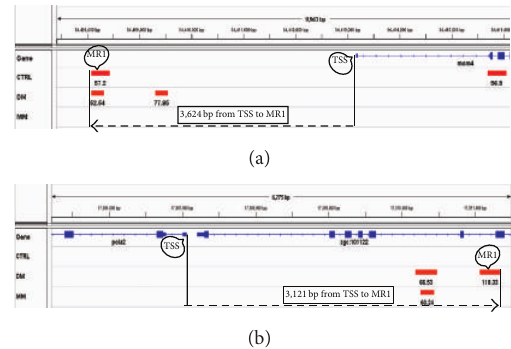
Figure 6: Methylated DNA regions (MRs) of zebrafish gene loci for mcm4 (a) and pola2 (b). Panels (a) and (b) were prepared with IGV genome viewer. The scale on the top shows chromosomal coordinates. This program schematically represents the structure of thegeneusingconventionalelements:(1)bluelinerepresentsintrons and (2) blue blocks on the line represent exons. Circles with the “TSS” point to the transcription start site and the dashed arrow points in the direction of 5 󸀠 to 3 󸀠 of the DNA strand with the arrow pointing to the MR farthest upstream of the TSS as indicated for each diagram (bp distance indicated in the box above the dashed arrow). Three tracks separated by gray lines below gene track show localization of MRs for each of the three samples to include control (CTRL), diabetic state (DM), and metabolic memory state (MM). Methylated regions detected by the MACS algorithm are shown as red boxes. MRs upstream of the TSS that have a loss of methylation in the DM and/or MM states are numbered (MR1, MR2, etc.) with theMACSpeakIDnumbersundereachMR.(a) mcm4 ,(b) pola2 .As shown in Figure 6(b), pola2 mimicked lig1 . Like lig1 , pola2 displayed upregulation of gene expression in the DM and MM states but showed no differential methylation pattern in the control state. Also like lig1 , pola2 was seen to have MRs detected in the DM and/or MM